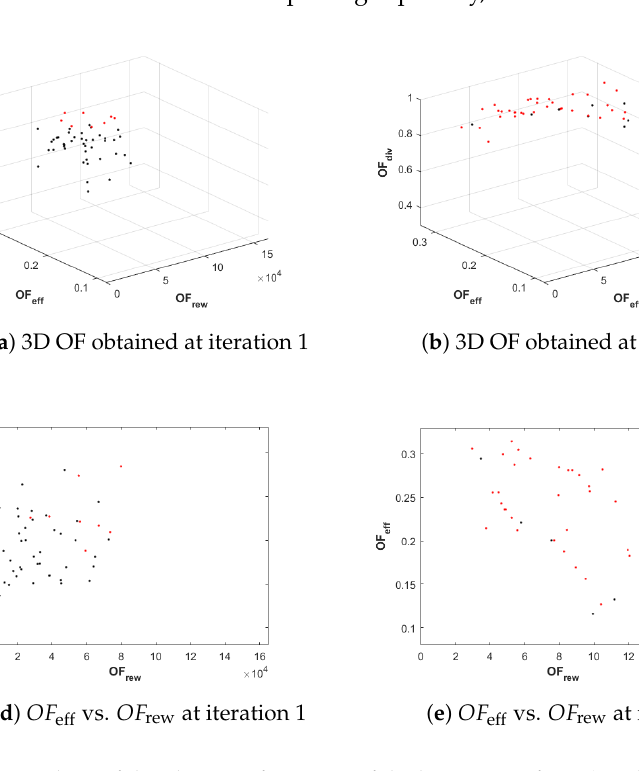
Figure 7. Values of the objective functions of the best Pareto front (marked in red) vs. values of the OFs of the remaining population (marked in black) for SC1 and PC1. The top row of graphics represent in 3D the values of the three OFs, while the second row only shows the values of two of them.